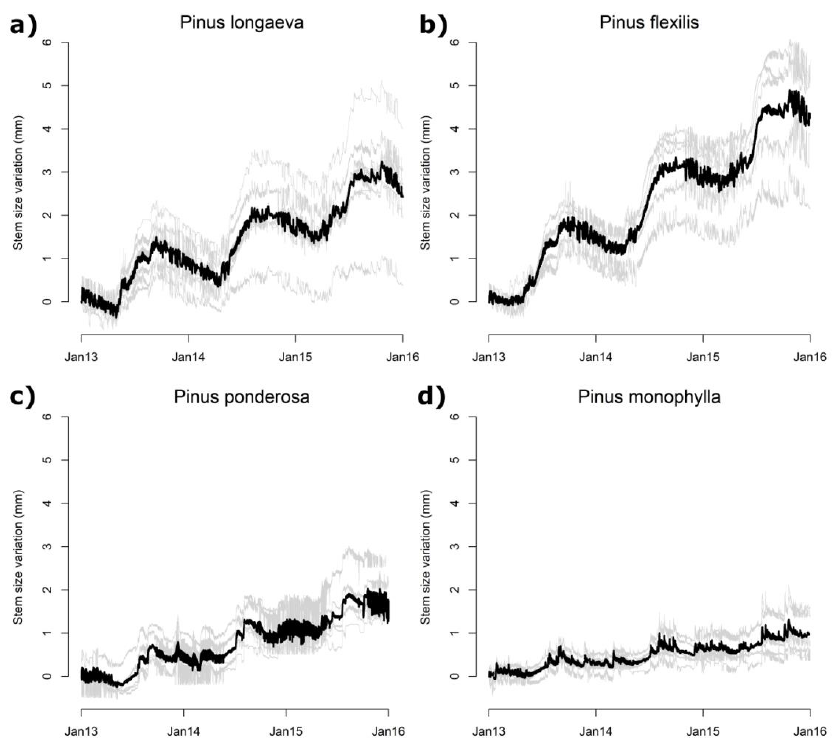
Figure 3. Half-hourly individual dendrometer tracks of stem size variation (gray lines) for PILO ( a ), PIFL ( b ), PIPO ( c ) , and PIMO ( d ) from 1 January 2013 to 31 December 2015. Black bold lines represent the site average. Species codes are the same as in the Figure 2 caption.